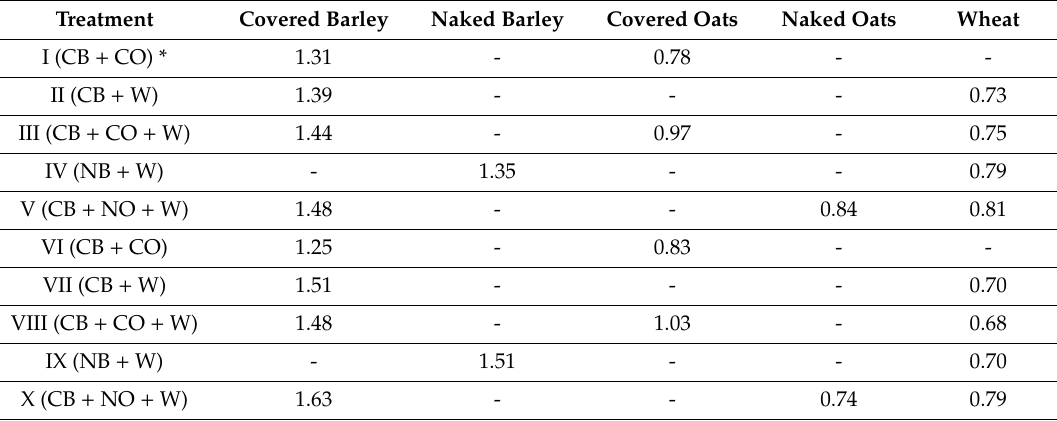
Table 11. Yield suppression ratio of the mixture components on the soil of Haplic Arenosols.